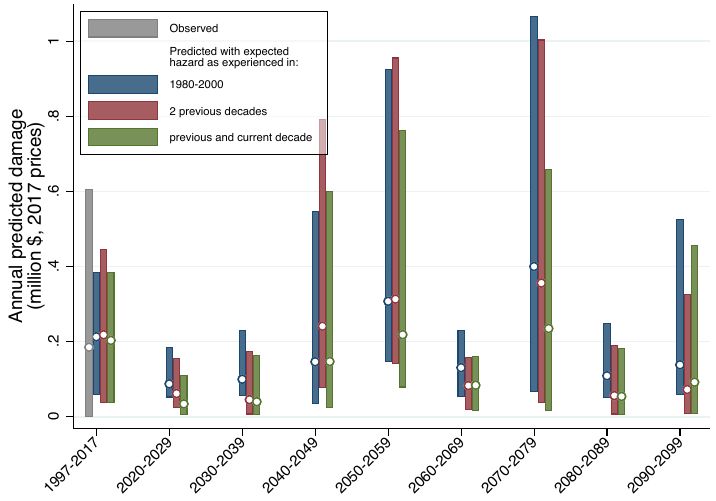
Figure 9. Annual flooding damage from 1997 to 2099 in the CRB. Observed and predicted damage in census blocks. Average levels and 95% confidence intervals computed over adaptation model calibration period, decades, and hazard expectation